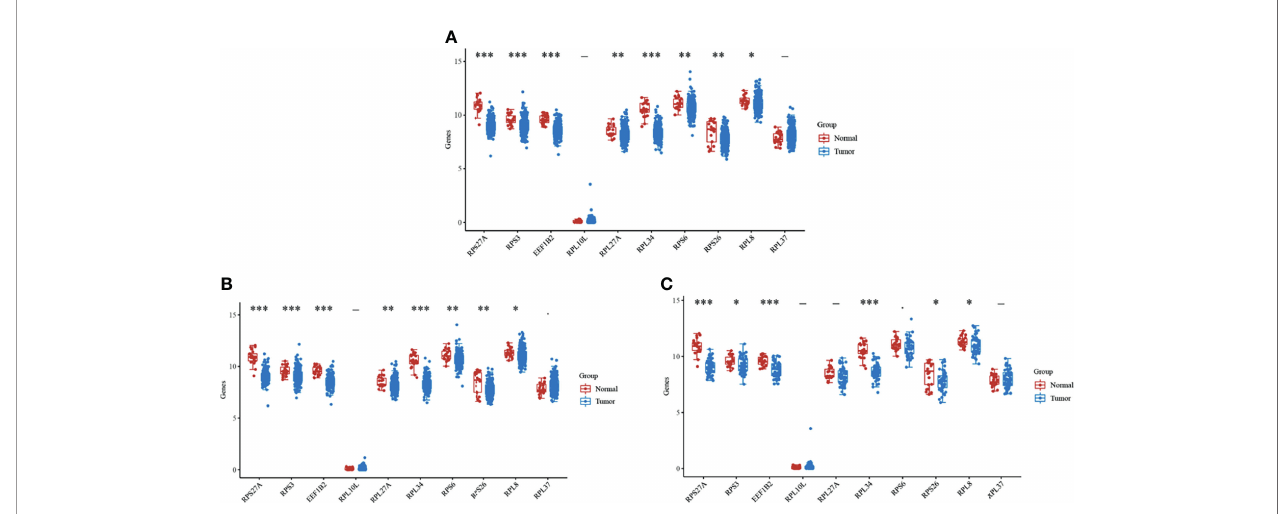
FIGURE 4 | Expressions of the 10 key genes in different cervical cancer types. (A – C) Differences in the expressions of the key genes in cervical cancer, cervical phospho-cellular carcinoma, cervical adenocarcinoma, and normal tissues, respectively. *P < 0.05; **P < 0.01; ***P <